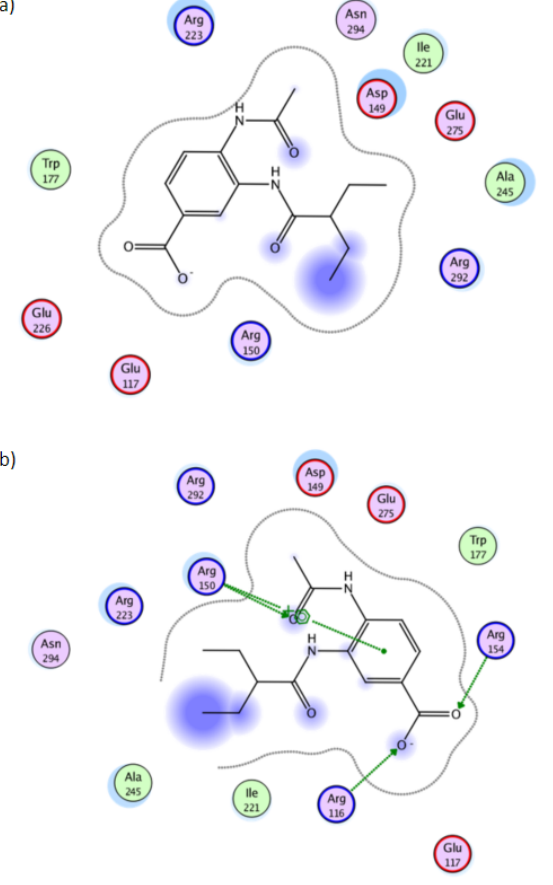
Fig. 5. Ligand interaction diagram in the X-ray structure of NA (PDB ID 1b9s)